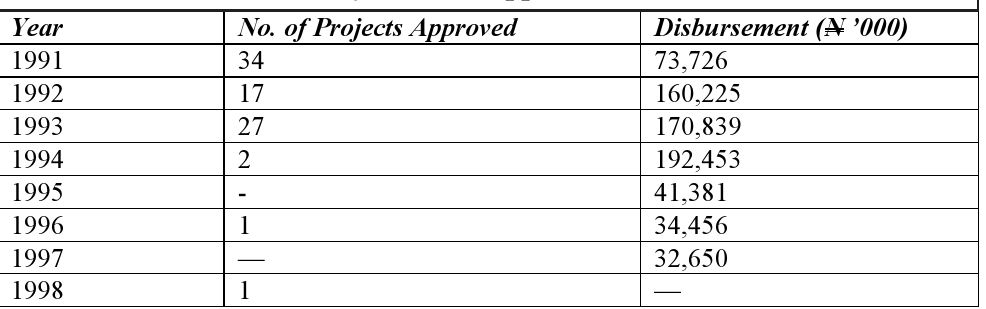
Table 6. Summary of NIDB’s Approval and Disbursement